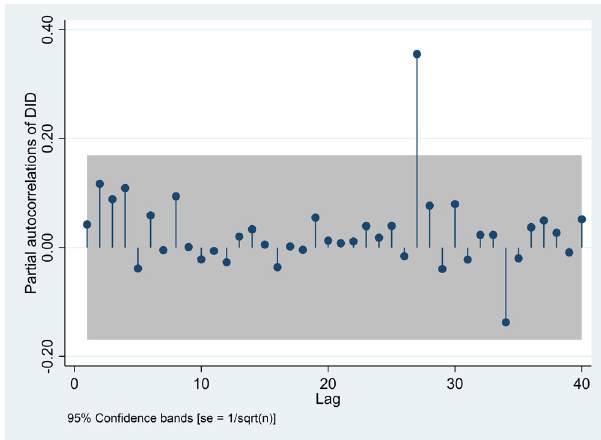
Fig. 10 First order differential